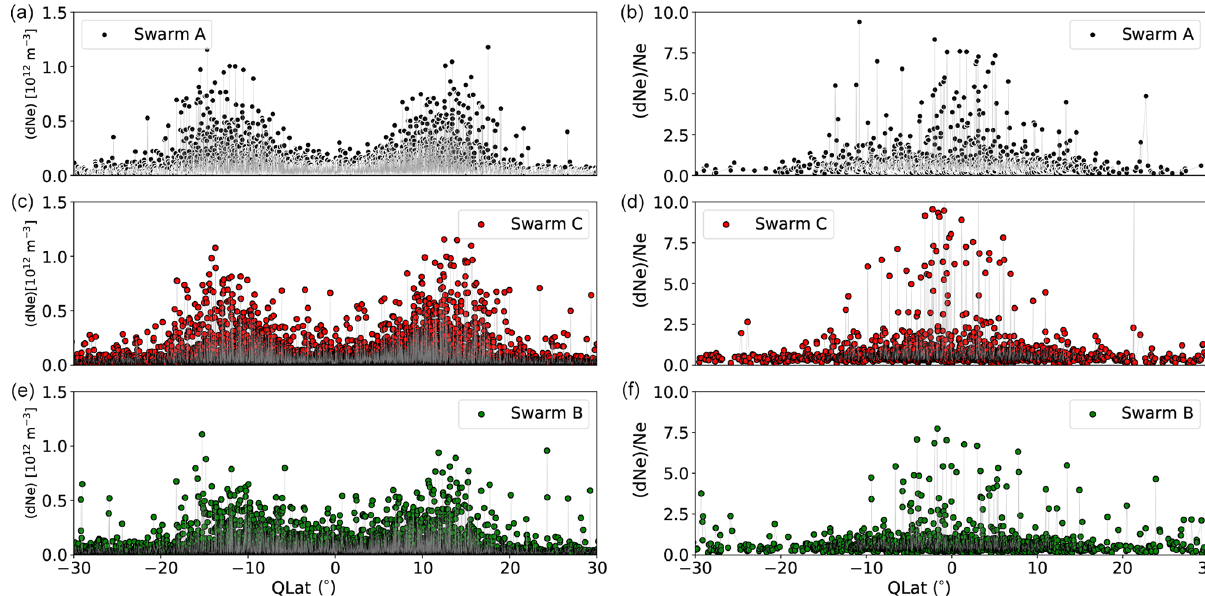
Figure 8. Scatter plots of the latitude distribution of ionospheric irregularities observed for the period from October 2014 to October 2018. The left panel shows the distribution when irregularities are quantified using dN e , while the right panel shows the distribution when dN e /N e is